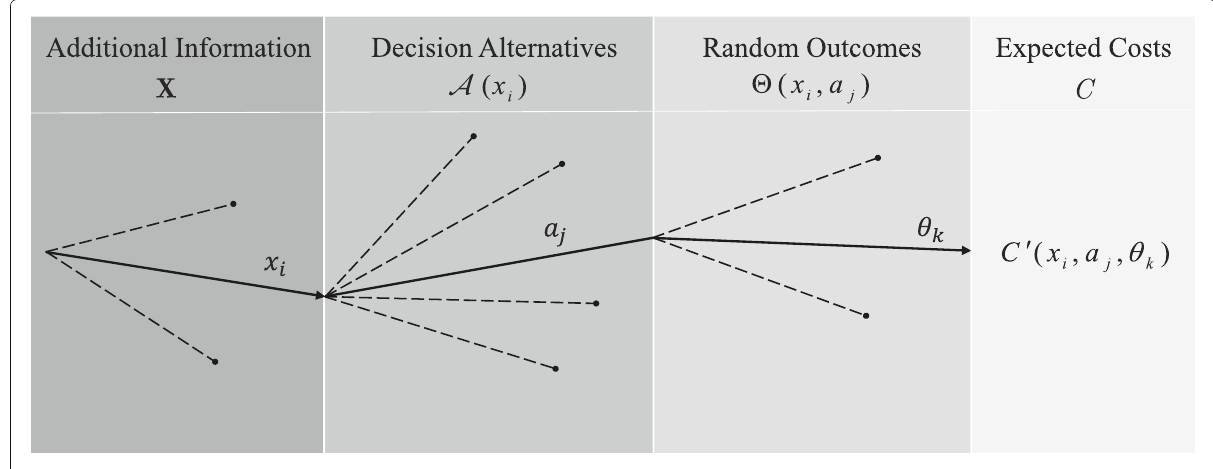
Fig. 4 Decision tree for posterior decision analysis